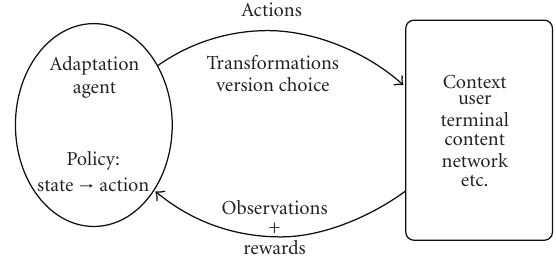
Figure 1: Context-based adaptation